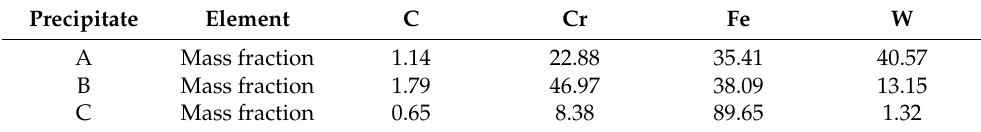
Table 2. Detailed chemical compositions of different types of precipitates